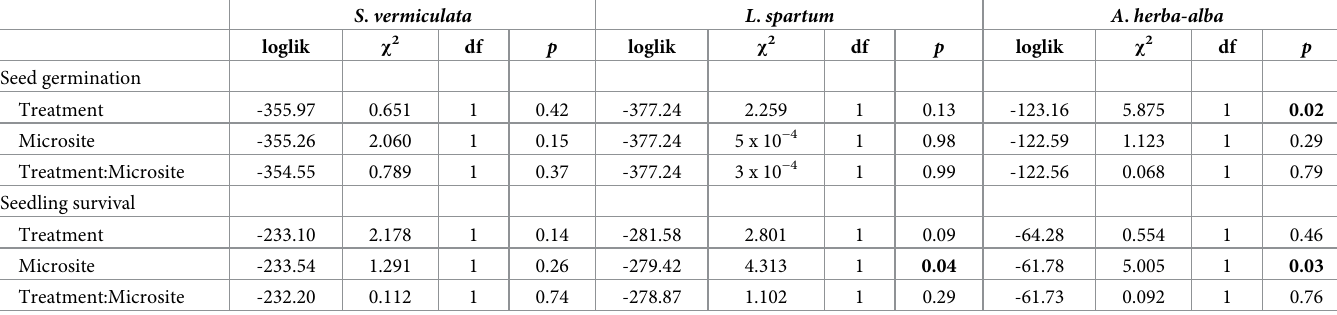
Table 2. Result of Cox regressions for the effect of treatment and microsite on the germination and survival of target species. S .